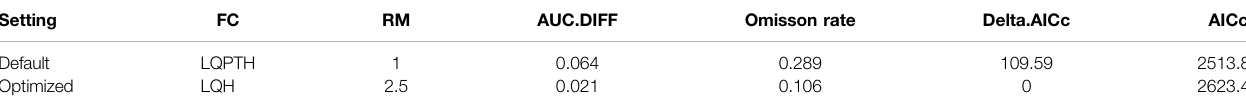
TABLE 2 | Metrics evaluating the optimal and default MaxEnt models by using the ENMeval package. Setting